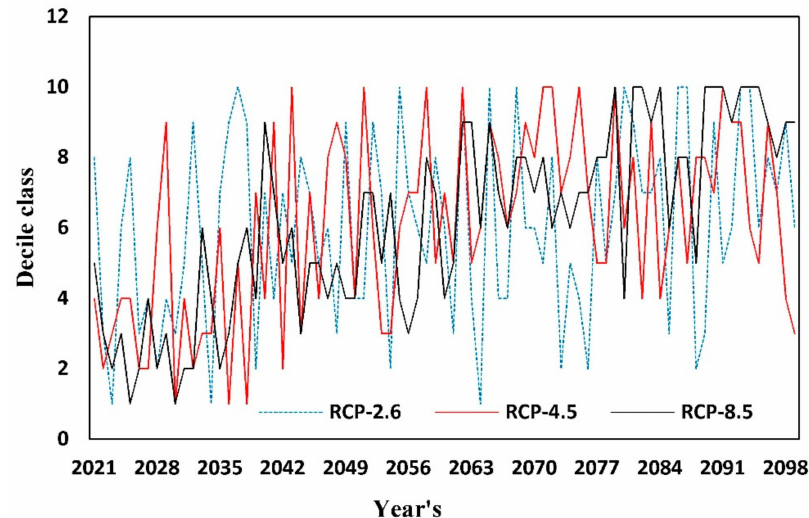
Figure 3. Drying pattern of Precipitation Decile (PD) under RCP 2.6, RCP4.5, and RCP